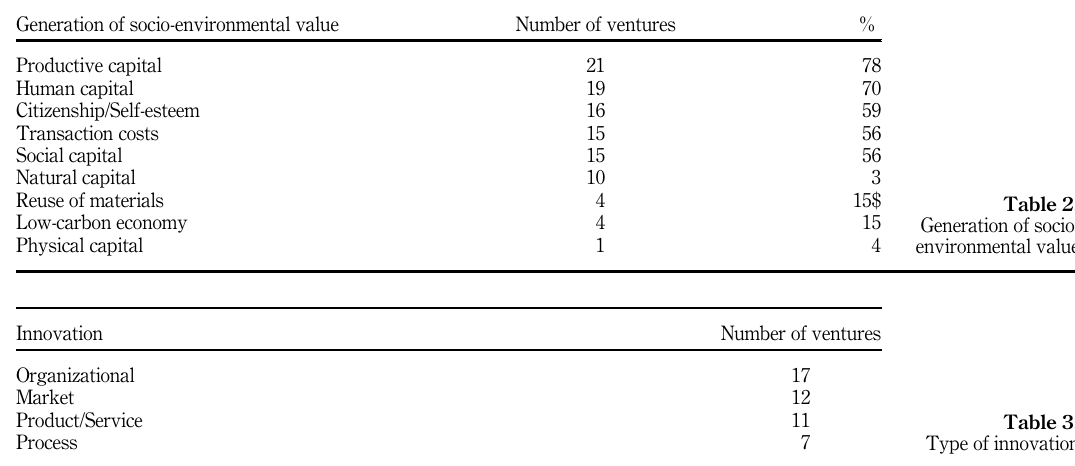
Table 3. Type of